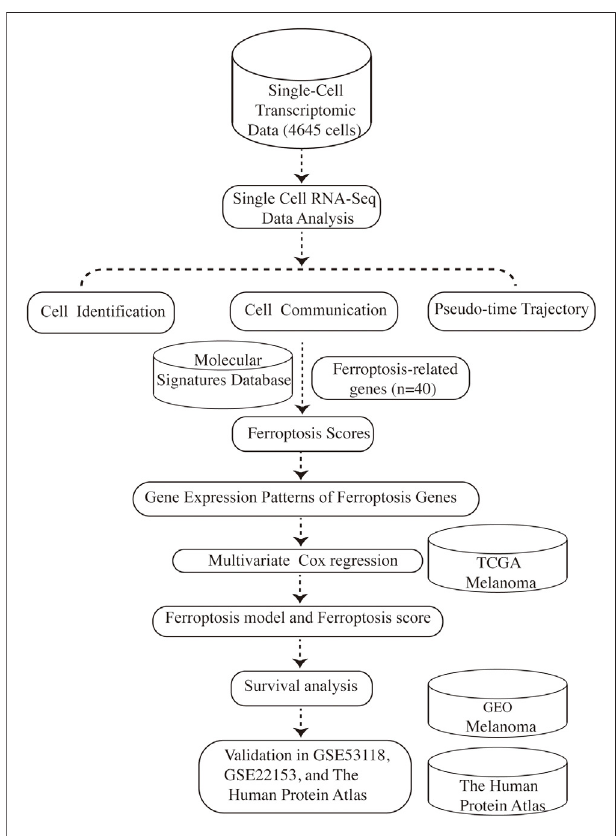
FIGURE 1 | Schematic depicting our study